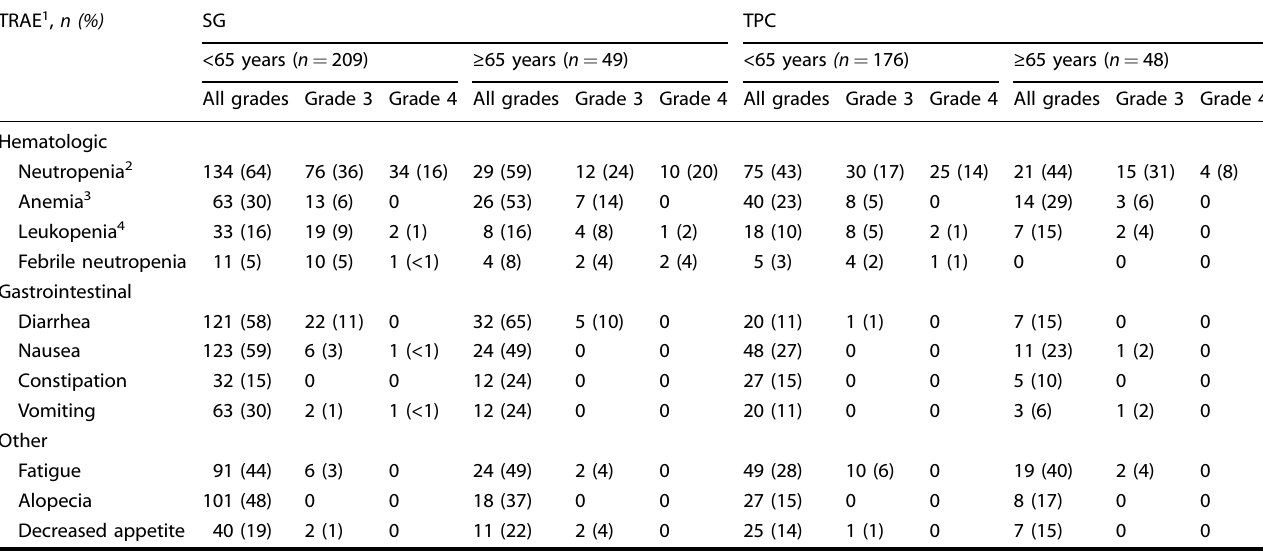
Table 2. Treatment-related adverse events of all grades reported in >20% and of grade 3 or 4 reported in >5% of patients by age. TRAE 1 , n (%) SG